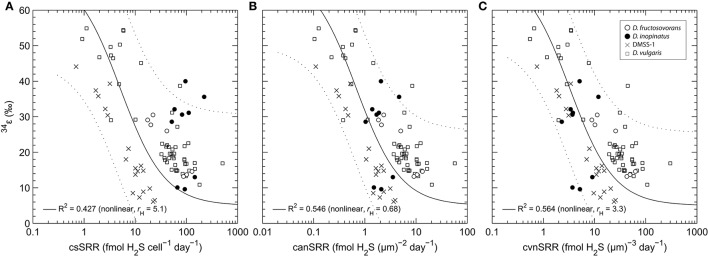
Comparison of correlations between (a)
34ε and cell-specific sulfate reduction rate (csSRR); (b)
34ε and cell area-normalized sulfate reduction rate (canSRR); and (c)
34ε and cell volume-normalized sulfate reduction rate (cvnSRR) for several Desulfovibrio spp. grown in culture under nutrient-replete conditions. In (a), the DMSS-1 and D. vulgaris (Hildenborough) data are from Sim et al. (2011b) and Leavitt et al. (2013), respectively. In (b,c), the sulfate reduction rates have been normalized using the cell size data shown in Table 4. The solid curve and coefficient of determination (R2) represent non-linear least squares fits of a model function through all data in each panel. Equations describing the curves are of the form: y = 34εmax − x · (34εmax−34εmin)/(rH+x), where 34εmax = 71‰ (equilibrium at ~20°C and pH ~7.0; (Millero et al., 1988; Otake et al., 2008)), 34εmin = 5‰ (high-rate asymptote, see Appendix), and rH is a fitted parameter that has the same units as the x-axis (it represents the sulfate reduction rate at which 34ε is halfway between its maximum and minimum limits). This equation was chosen because it can closely approximate model results of Wing and Halevy (2014) for the typical range of csSRR observed in experiments (see Appendix), and because R2 for fits to this equation are uniformly higher than for linear least squares regressions of 34ε against the log-transformed rates. Dotted envelope marks the non-simultaneous 95% prediction band.